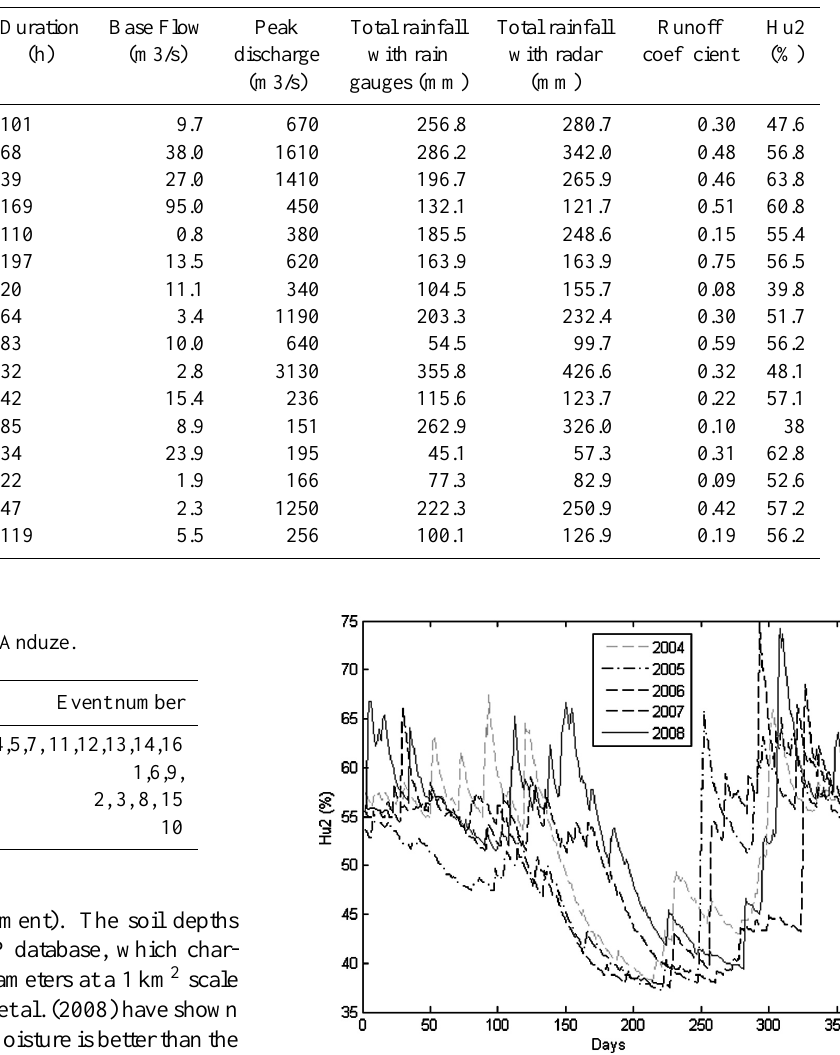
Fig. 4. Averaged Hu2 values over the Gardon of Anduze catchment